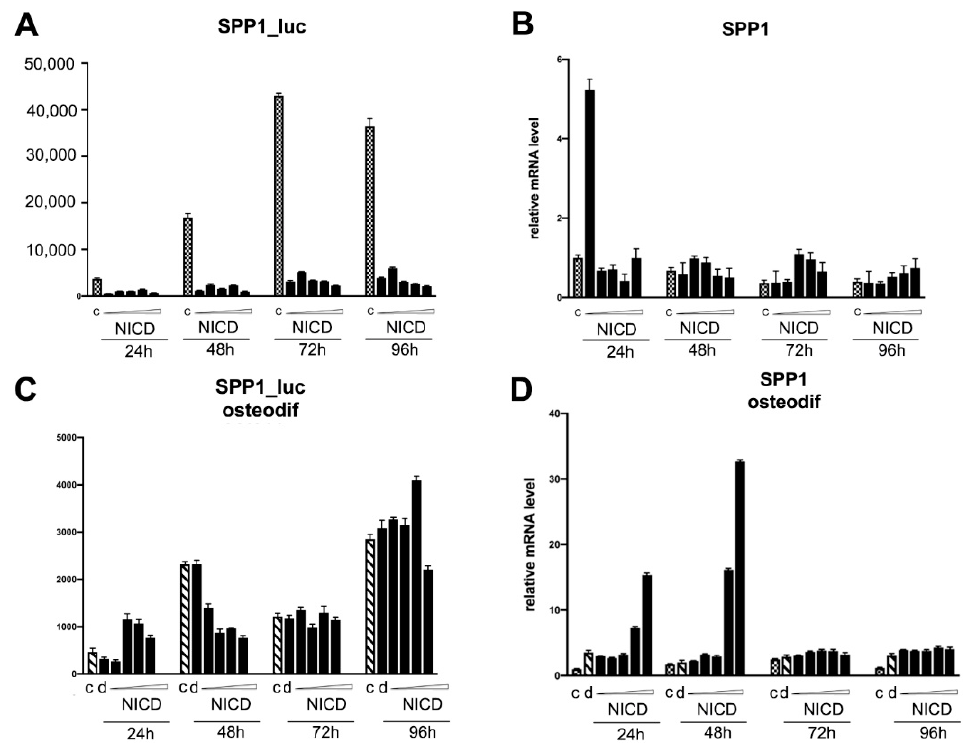
Figure 6. Analysis of dose-dependent Notch activation influence on SPP1 promoter activity ( A , C ) and SPP1 transcription ( B , D ) in mesenchymal stem cells (MSCs) of adipose tissue in non-osteogenic ( A , B ) and osteogenic conditions ( C , D ). The cells were transduced with the construct bearing CSL-luciferase reporters and subsequently with various doses of NICD-bearing viruses, and were analyzed in non-osteogenic and osteogenic conditions after indicated periods of time.